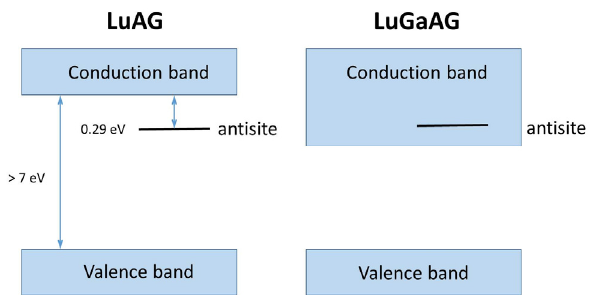
Figure 11. Schematic of the band structure of undoped LuAG (left) with the antisite defect in the band gap 0.29 eV below the conduction band, compared to the band shift due to Ga admix, where the defect level is no longer in the forbidden gap (From [97]).